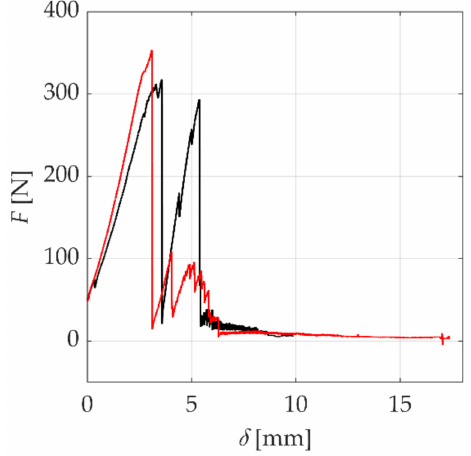
Figure 20. Tensile force F measured in the Sisal strand tensile tests for two